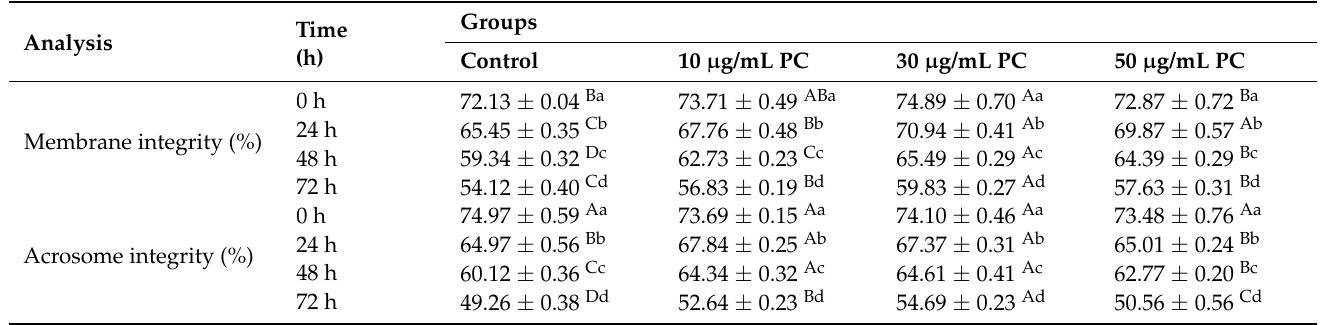
Table 3. Effects of different concentrations of procyanidin on dog sperm plasma membrane integrity and acrosome membrane integrity after being stored at a cool temperature for 72 h.